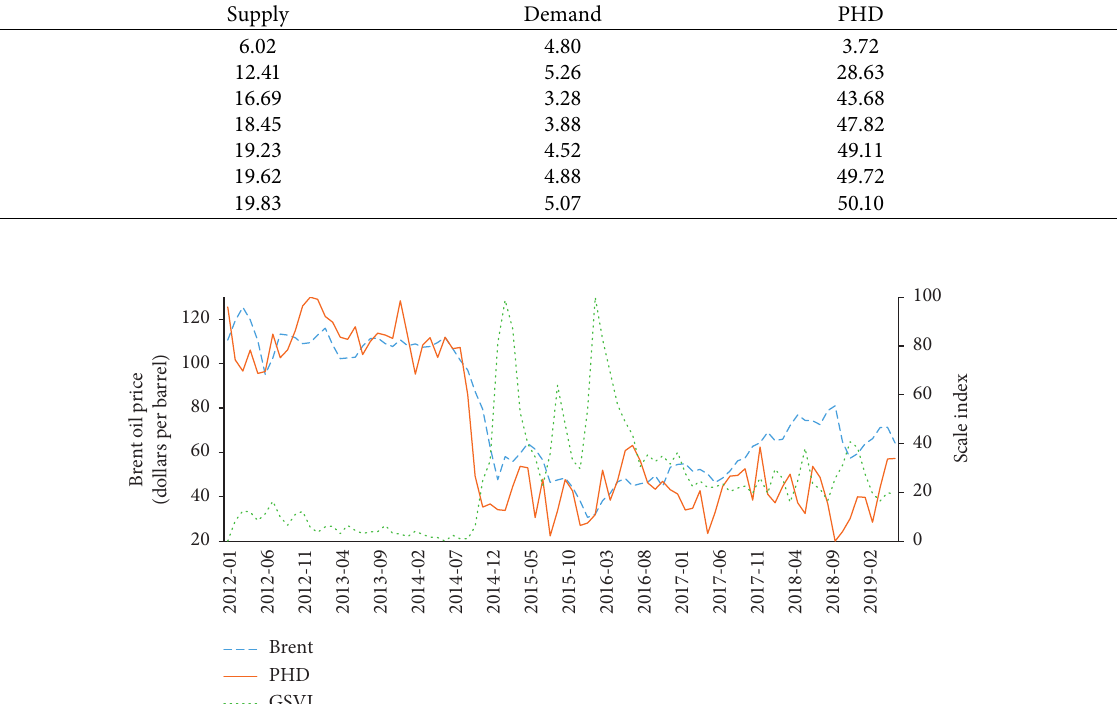
Figure 5: Responses of Brent oil prices to different shocks based on VAR N . The blue solid lines represent the mean impulse response of Brent oil prices and the red dotted lines denote two standard deviations from the mean. The response period is 30 months. (a) Response of Brent oil prices to a supply shock. (b) Response of Brent oil prices to a demand shock. (c) Response of Brent oil prices to a NHD Table 7: Results of variance decomposition of Brent oil prices based on VAR P (%).